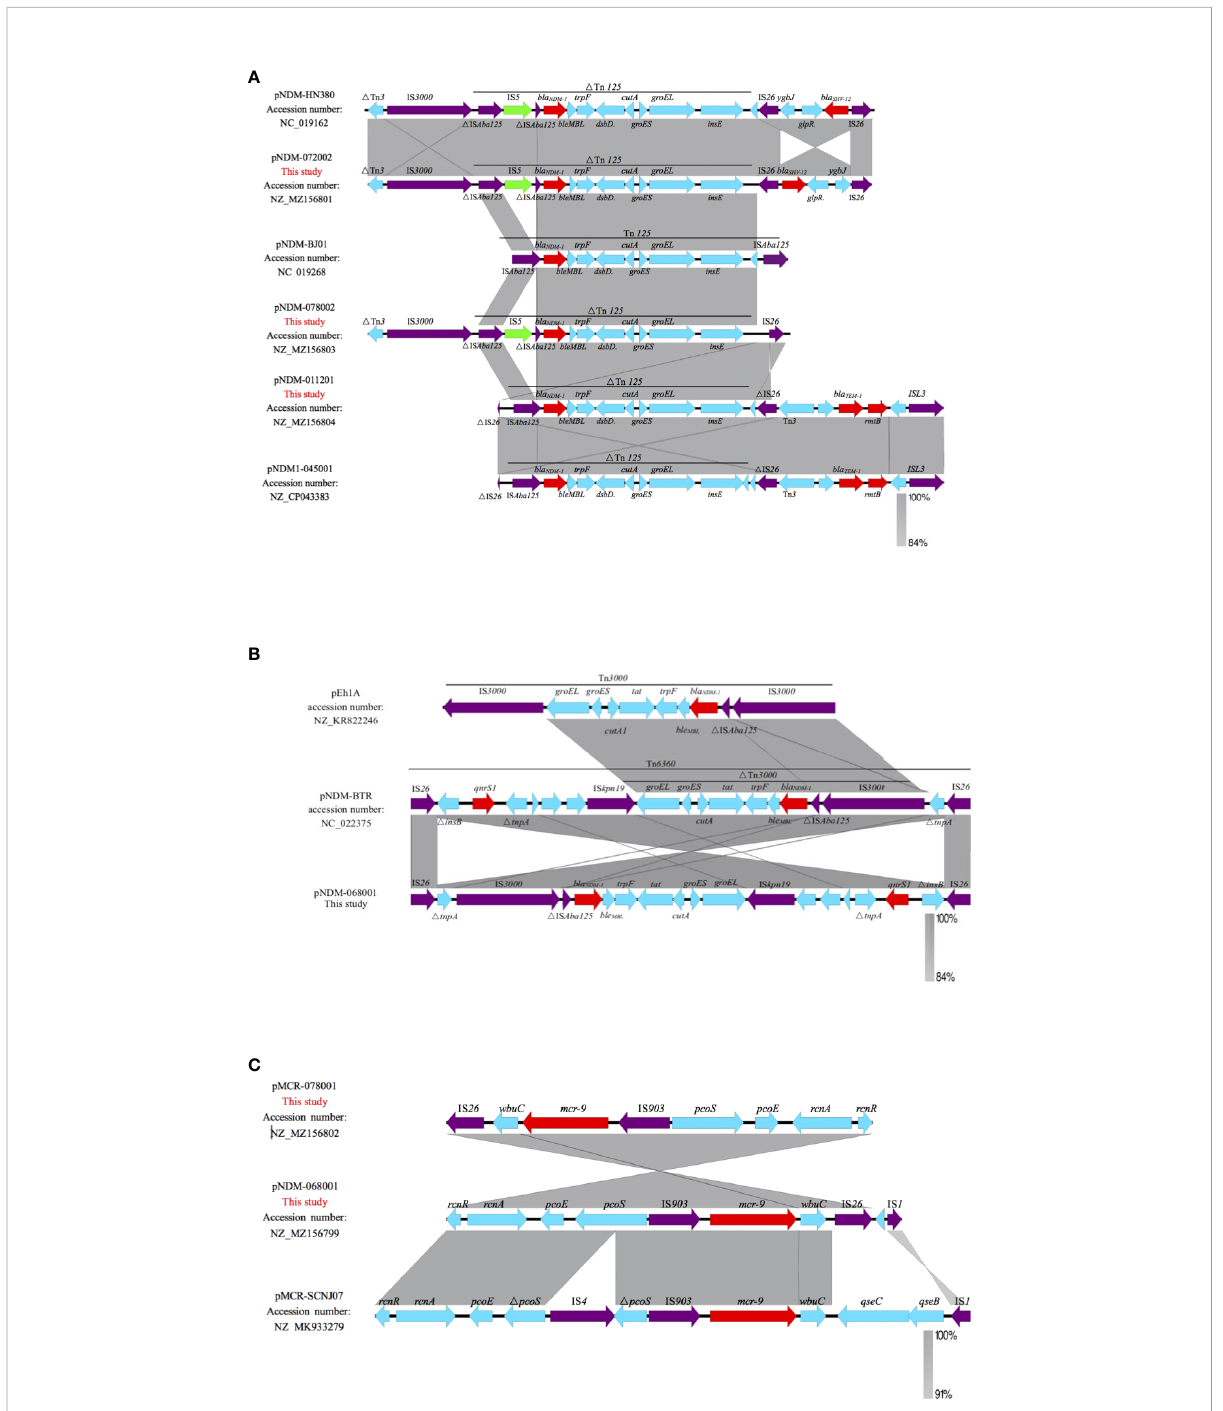
FIGURE 4 Linearized analyses for genetic environment of bla NDM-1 and mcr-9 . (A) bla NDM-1 harbored by pNDM-HN380, pNDM-072002, pNDM-BJ01, pNDM-078002, pNDM-011201, and pNDM-045001. (B) bla NDM-1 harbored by pNDM-068001, pEh1A, and pNDM-BTR. (C) mcr-9 harbored by pMCR-078001, pNDM-068001, and